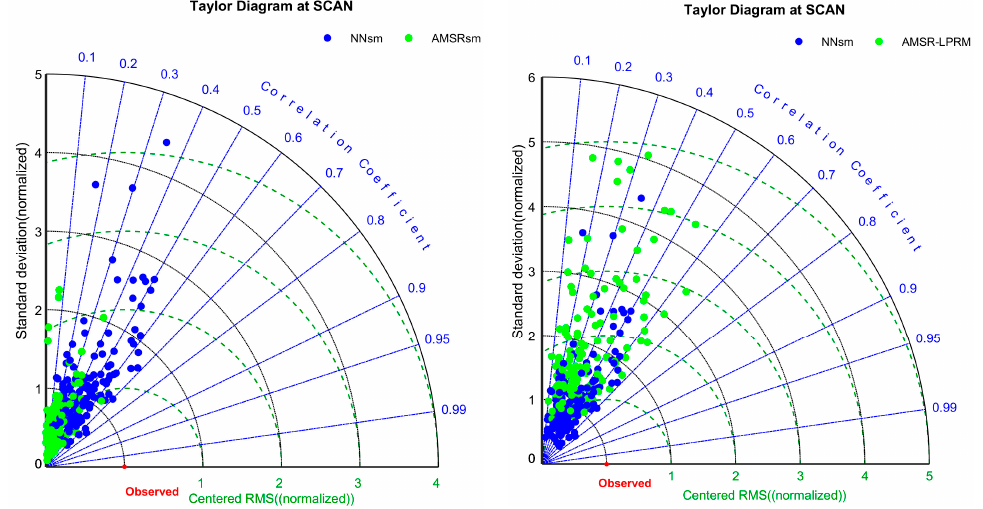
Figure 11. Taylor diagram displaying a statistical comparison between NNsm (blue dots) and AMSRsm/AMSR_LPRM (green dots) (left panel is AMSRsm, right panel is AMSR_LPRM) with the time series of in situ SCANsm (red dot) over the long time period (2003–2015).